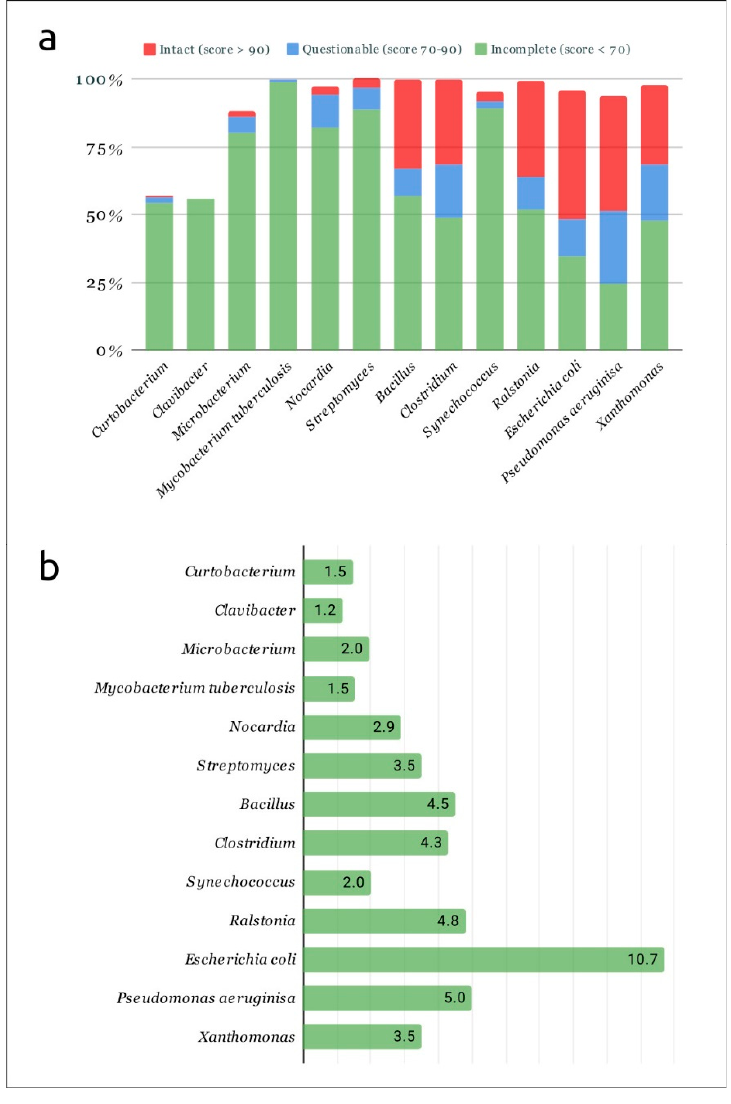
Figure 1. ( a ) Percentage of genomes of different analysed taxonomic groups where PHASTER predicted the presence of prophages. Scoring was carried out according to the PHASTER criteria [37]. ( b ) Average number of prophages per genome predicted with PHASTER, where the prophages were detected.